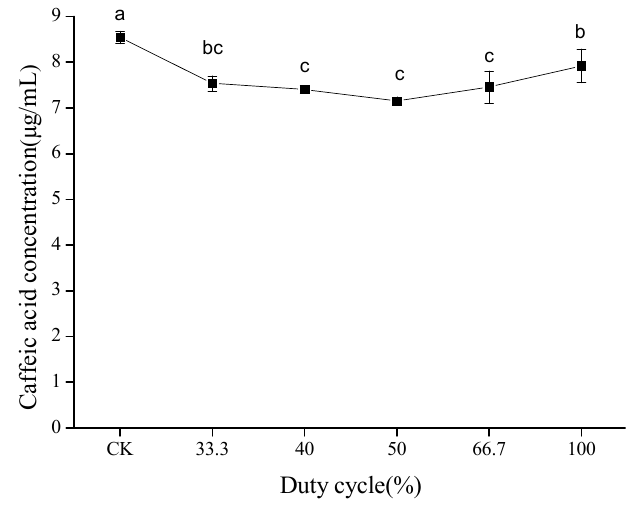
Figure 5. Effect of duty cycle on the stability of caffeic acid under ultrasound treatment (US).